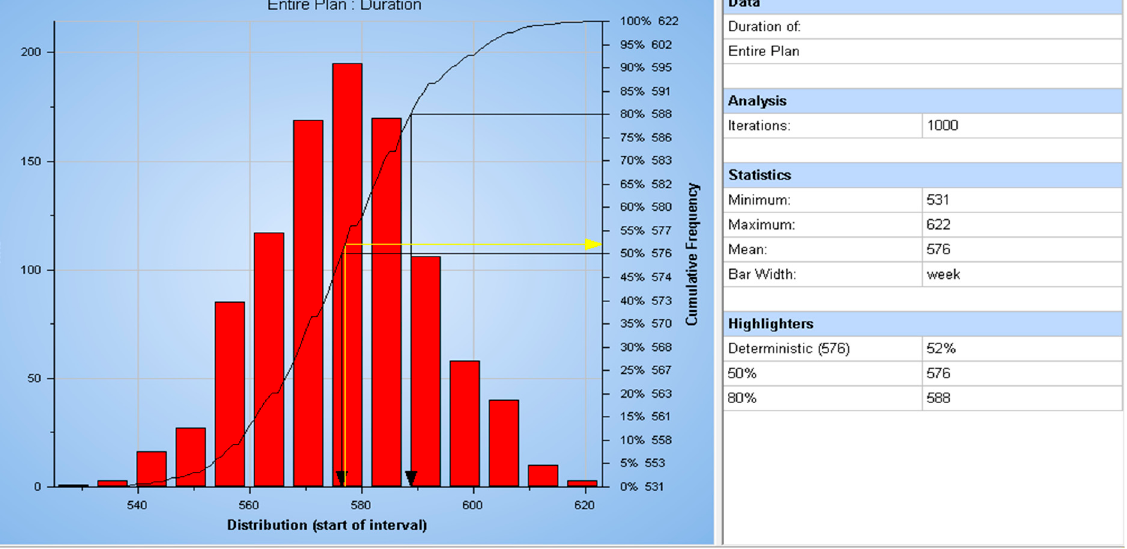
Figure 8. Histogram of the duration of the original project plan.